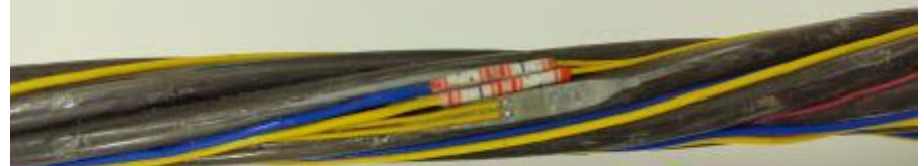
Figure 1. Measuring point figure of bird’s nest anchor cable.